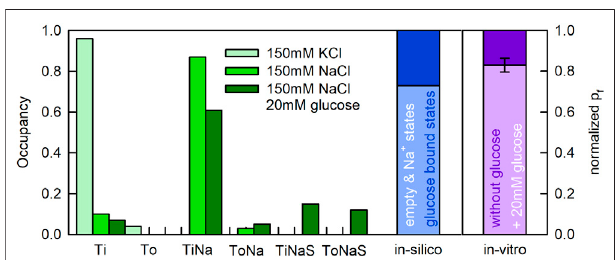
FIGURE 7 | State occupancies of SGLT1 during water fl ux though the transporter. Upper panel To and Ti represent the outward and inward facing apo-conformations, respectively ( Figure 8 ). ToNa, TiNa, ToNaS, and TiNaS denote the sodium and the sodium/glucose bound states. State occupancies were averaged over the fi rst 100 ms after application of the osmolyte ( Figure 6 ). We used the same color code as in Figure 6 to indicate the different experimental conditions. The bar in blue shows the summed fraction of the substrate bound states (dark blue) and, the summed fraction of the substrate free states (light blue). The difference between the light purple and dark purple bar shows the decreased unitary water permeability measured in the presence of 20 mM glucose. Lower panel Simulated water permeability of SGLT1 (assuming water impermeable glucose states) as a functionoftheglucoseconcentration(bluedots).Thegreencurvedenotesthe fi t of an inhibition curve to the data: P (cid:2) b + ( a − ( a · [ S ])) / ([ S ] + IC ) The f 50 extracted IC 50 value was 10.81 mM (simulation conditions: 150 mM NaCl, 20 mM MOPS, and pH 7.5 with 4.3 hSGLT1 ’ s per vesicle +150 mM sucrose outside the